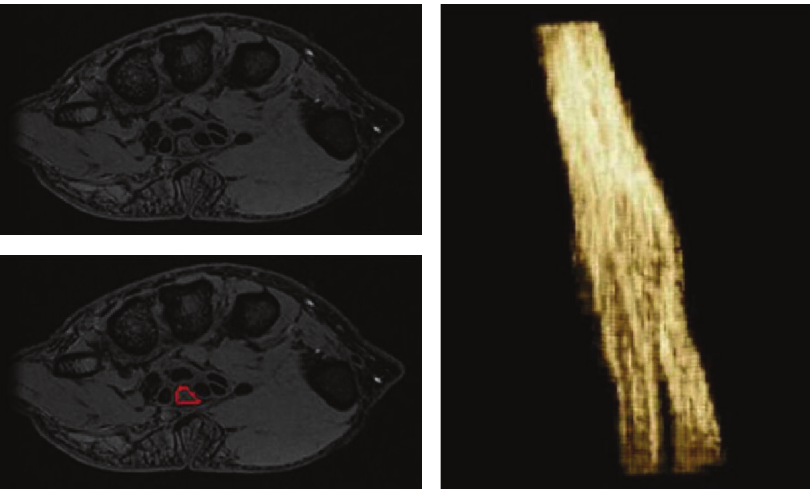
Figure 15: Nerve segmentation-Median nerve segmentation using custom made software. The tool allows semiautomated nerve segmentation, while a user draws region of interest on the nerve on sequential axial